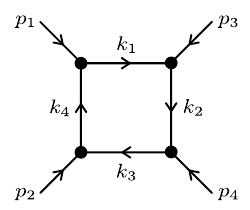
Figure 28: Directed box graph. Table 3: The incidence matrix a of the box graph in figure 28. The columns ij